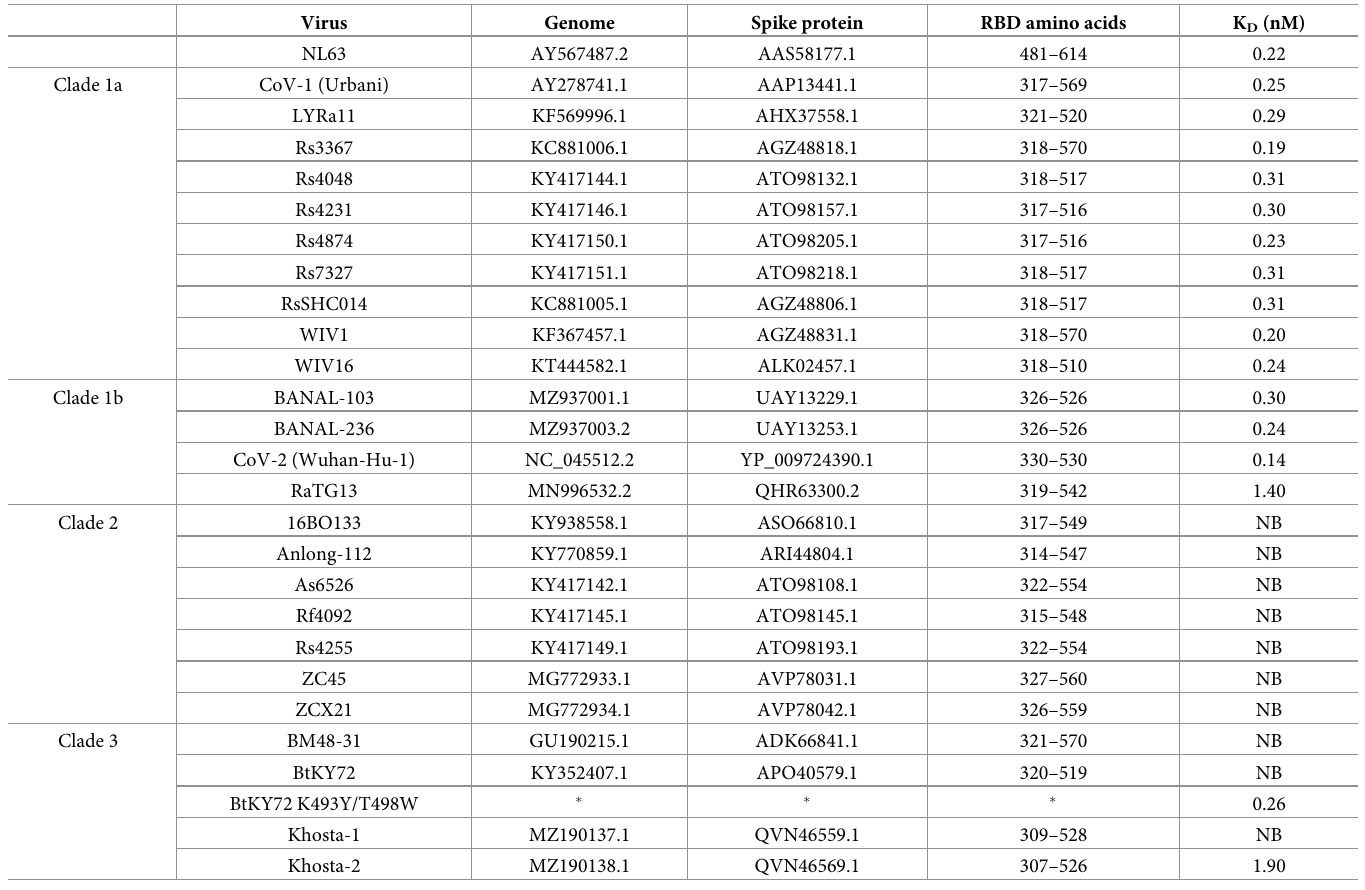
Table 2. Sarbecovirus RBD sequence and decoy binding